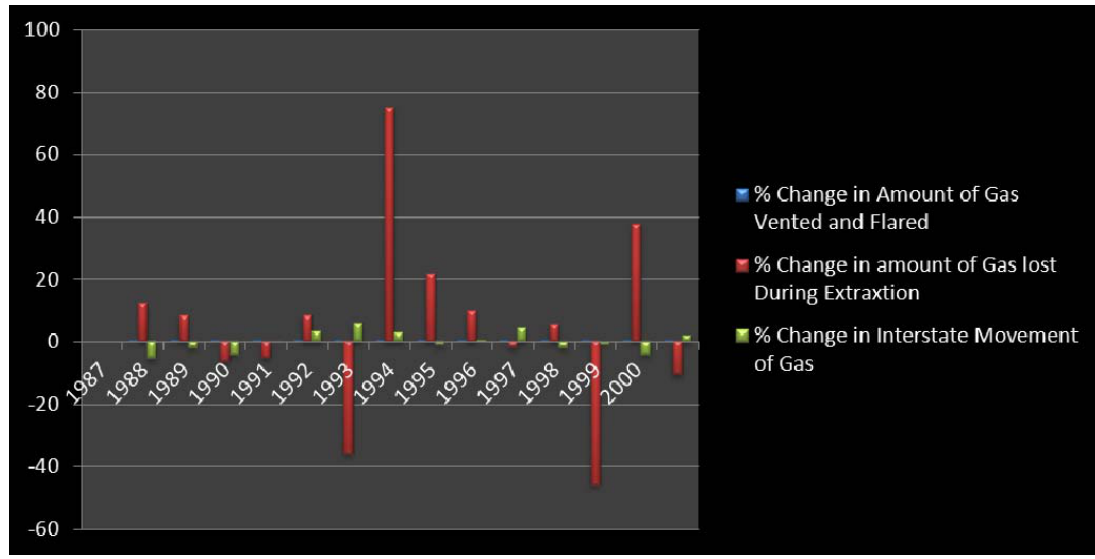
Figure 7. Graphical Summary of the Percentage of Change.